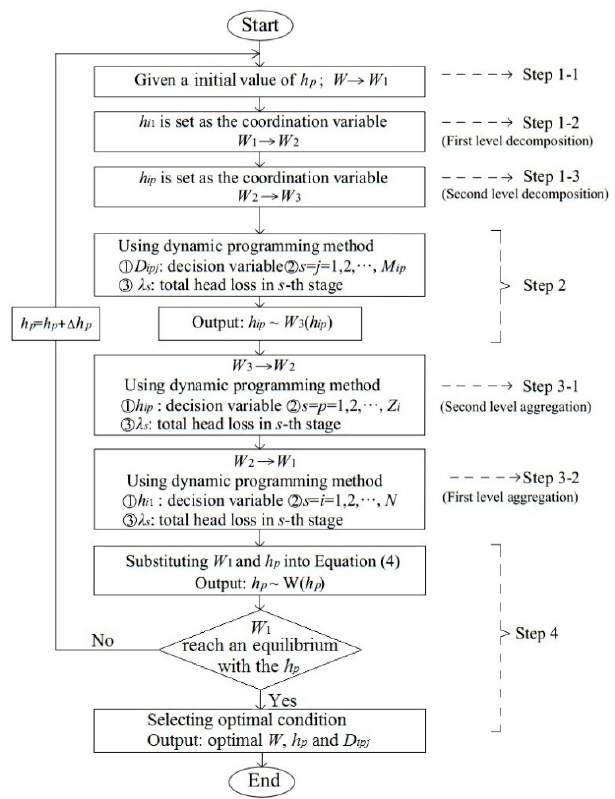
Figure 2. Flowchart of the proposed methodology.